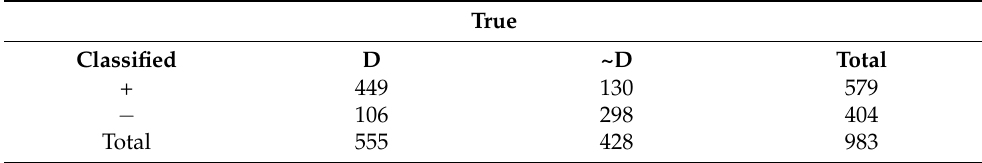
Table 7. Classification results for the logistic model.